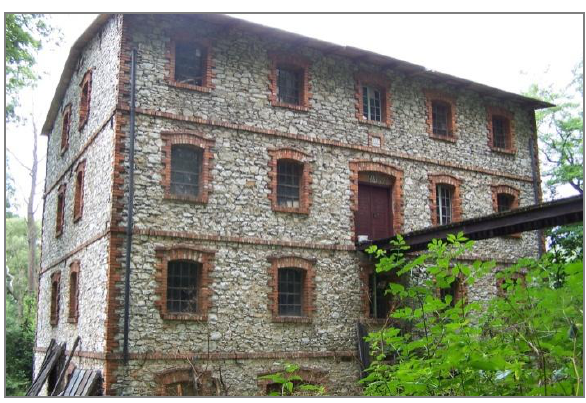
Fig. 4. Mill in Troniny on the River Liswarta ( M. Fajer )